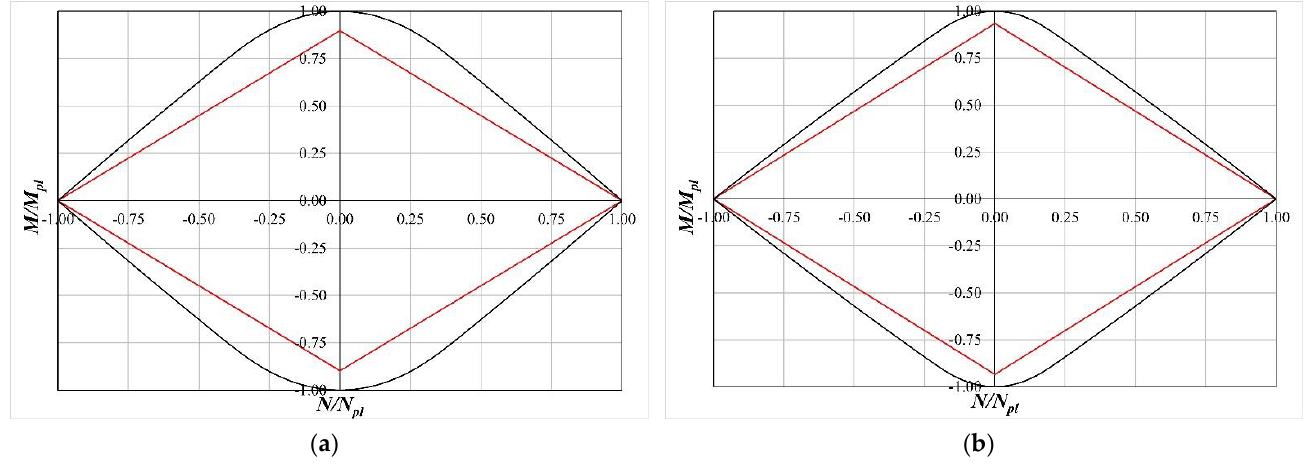
Figure 10. Dimensionless elastic (red line) and yield (black line) domains: ( a ) IPE400; ( b ) HEA300.